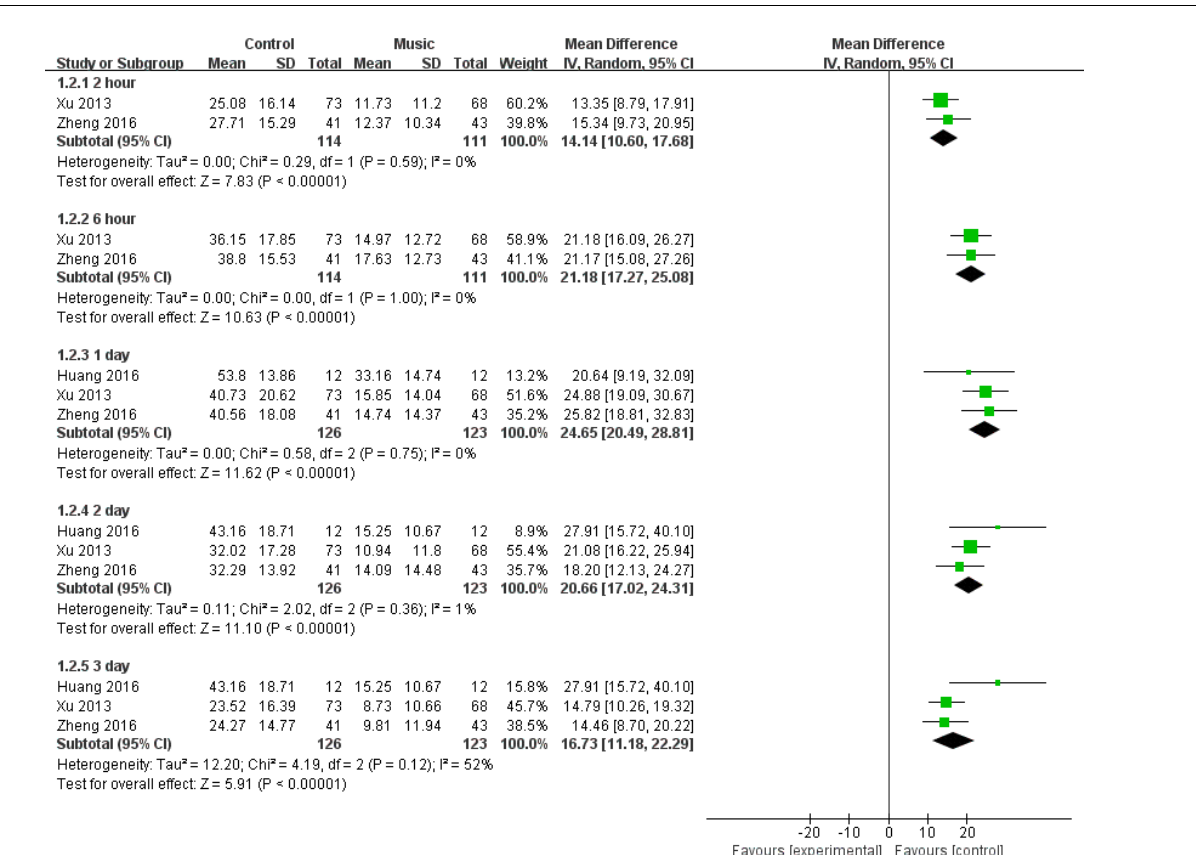
evidence favouring music therapy for pain reduction effectiveness daily within three days after activation of fixed orthodontic treatment.